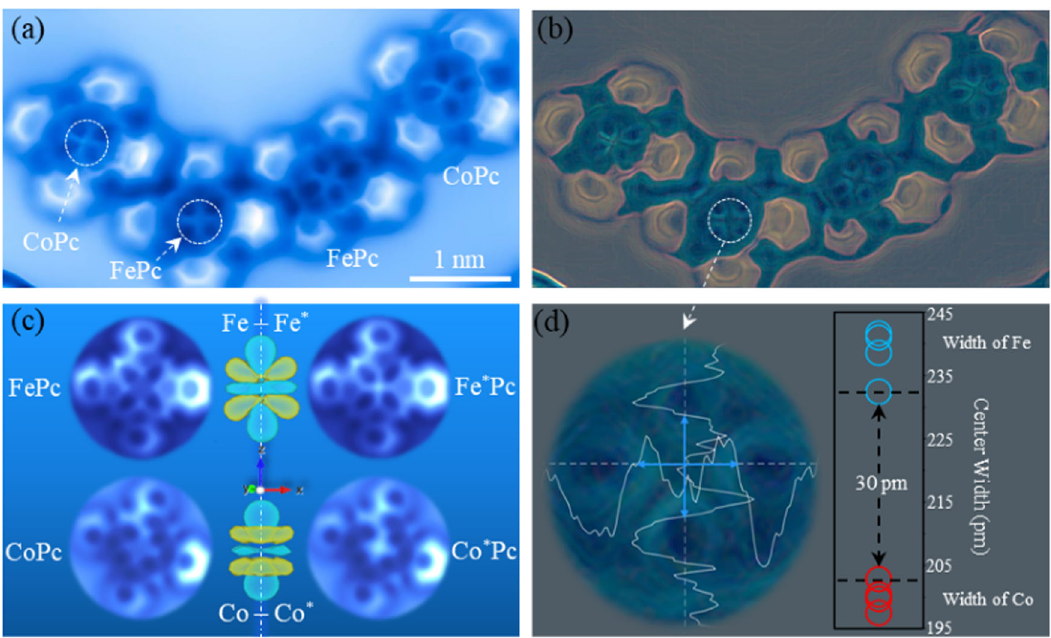
Fig. 2 | AFM images of FePc and CoPc on a Cu(111) surface. a Experimental constant-height AFM frequency-shift images ( V =0V, tip amplitude=100pm) usingaCOtipatatipheightof − 10pmwithrespecttoour100mV/100pASTMset point. The two white dashed circles highlight the main differences between these two molecules — the central metal atom. b Glow-edges fi ltered experimental AFM image(basedon a ). c SimulatedAFMimageswithaCOtipatatipheightof − 10pm (see Supplementary Informationfor the de fi nitionoftip height insimulation).Left panel: spin-polarized DFT calculations; right panel: spin-paired DFT calculations (indicated by a superscript *). On the midline, the orbital-like fi gures are the cal- culated total electron density differences between MPc and M*Pc (MPc – M*Pc).